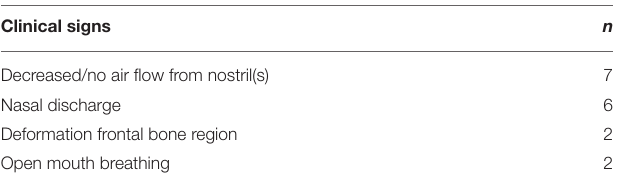
TABLE 2 | Clinical signs encountered in seven cases with sino-nasal obstruction in miniature horse breeds. Clinical